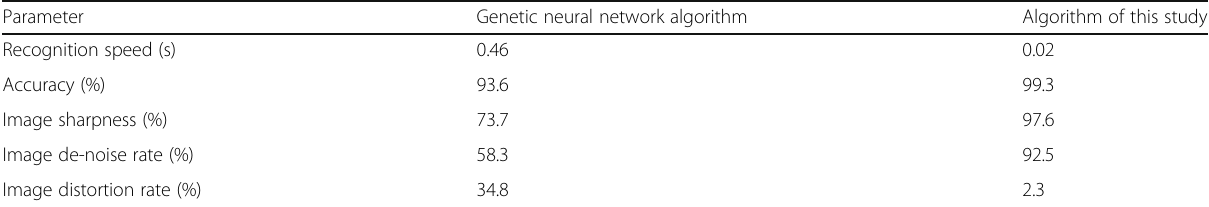
Table 1 Comparison of English image translation performance between the algorithm of this paper and the genetic neural network algorithm Parameter Genetic neural network algorithm Algorithm of this